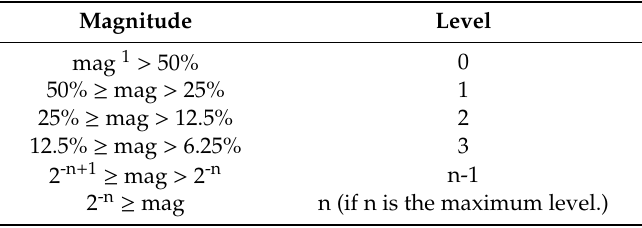
Figure 3. The flow of image retrieval. w and h represent the width and height of the image block, which has a fixed size, respectively. (x1, y1) is the upper left coordinate and size of the viewport (the red box in the figure); w1 and h1 are its sizes. w, h, and (x1, y1, w1, h1) are employed to calculate row and column numbers of image blocks (row, col). Magnitude is the scale of the image, and it is used to calculate the level of the image pyramid. The layer is the number of the sequence image. The level, row, col, and layer construct the indexes of image blocks for retrieval. Table 2. The transformation between magnitude and